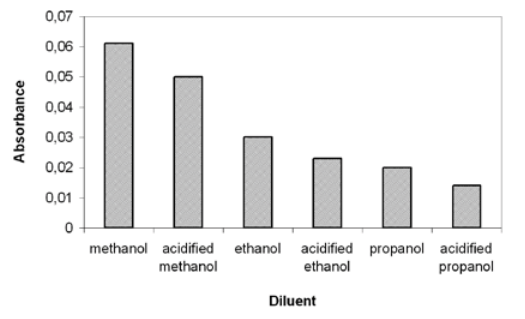
Figure 4. Effect of different diluents on the analytical signal of gold after its separation by CPE. Conditions: 100 ng mL -1 Au, 5×10 -6 mol L -1 brilliant green, 0.05% (v/v) Triton X-114, 0.1 M hydrochloric acid